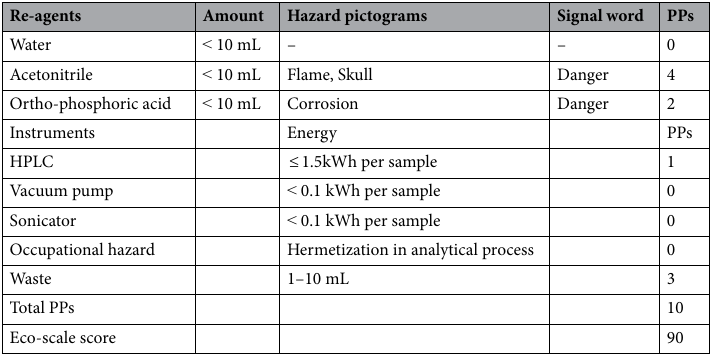
Table 5. Penalty points (PPs) of the proposed method according to the analytical eco-scale assessment